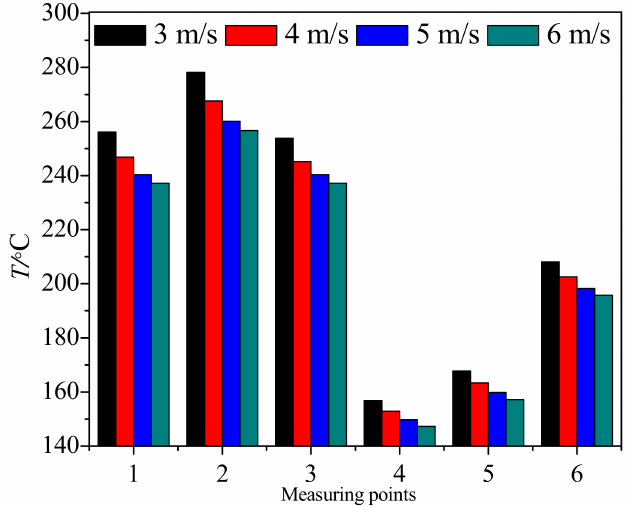
Figure 5. Effects of cooling-water inlet velocity on